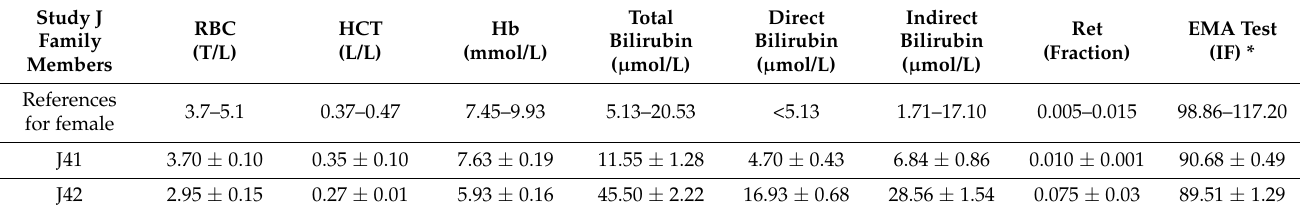
Table 1. Hematological characteristics of studied family members. * IF—mean fluorescence intensity; HCT—hematocrit; Hb—hemoglobin; Ret—reticulocytosis. Study J Family